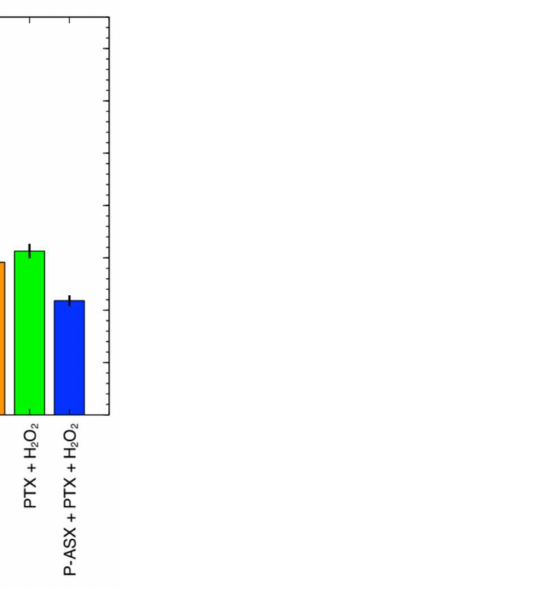
Figure 3. Effects of PTX and ASX-loaded microparticles on intracellular ROS as evaluated by flow cytometry with the DCF-DA probe. Cell fluorescence was almost equal for untreated cells (cell autofluorescence, ctrl) or cells treated with DCF-DA (probe), ASX microparticles (P-ASX), PTX or with P-ASX and PTX. Cell fluorescence significantly increased in cells loaded with DFC-DA and treated with H 2 O 2 , but treatments with PTX and ASX microparticles given alone or in combination significantly suppressed the effects of H 2 O 2 (see Figure 4 and Table 1 for statistical details). Data are the mean ± SE of 4 independent